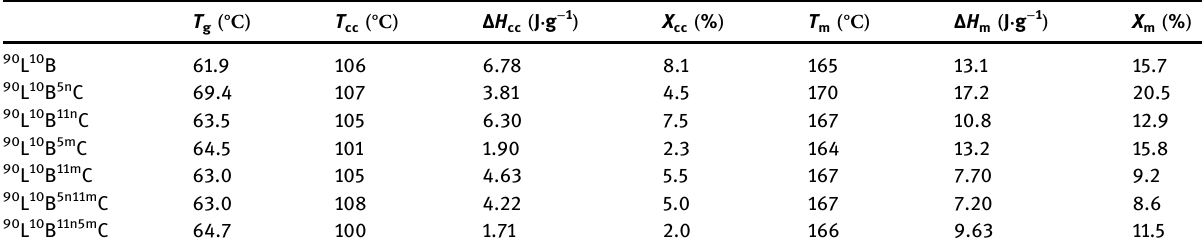
Table 3: Parameters derived from the fi rst heating DSC scans